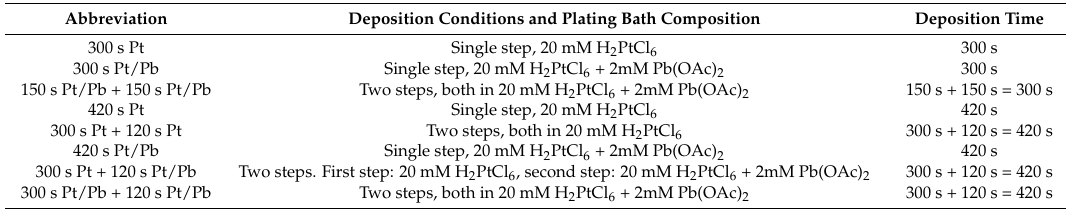
Table 1. Description of the different deposition conditions, plating bath compositions, and